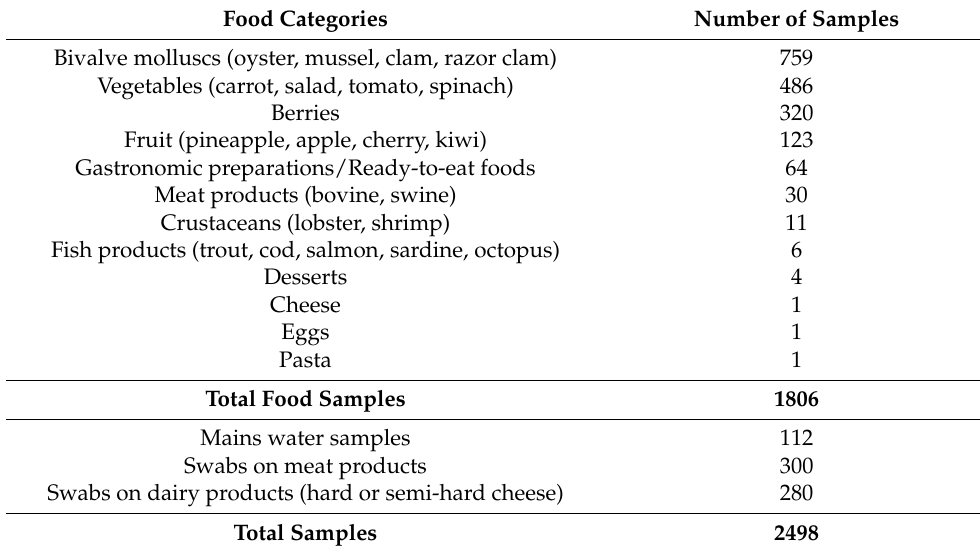
Table 3. Number and categories of food, mains water, and swab samples collected in Northern Italy and analyzed from 2020 to 2022 to detect SARS-CoV-2 RNA. In brackets the details of the products included in the sampling are